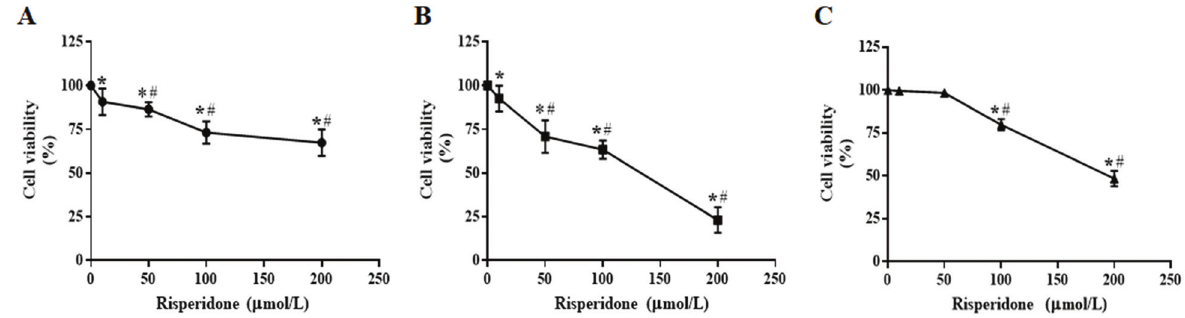
Figure 1. MC3T3-E1 cell viability after risperidone treatment. Viability curve at 24 ( A ), 48 ( B ), and 72 h ( C ) after administration of different concentrations of risperidone. Data are reported as means ± SD, from three independent experiments. *P o 0.05, comparing different doses of risperidone-treated group with the control group. # P o 0.05, comparison of present dose with previous dose of treated group (one-way